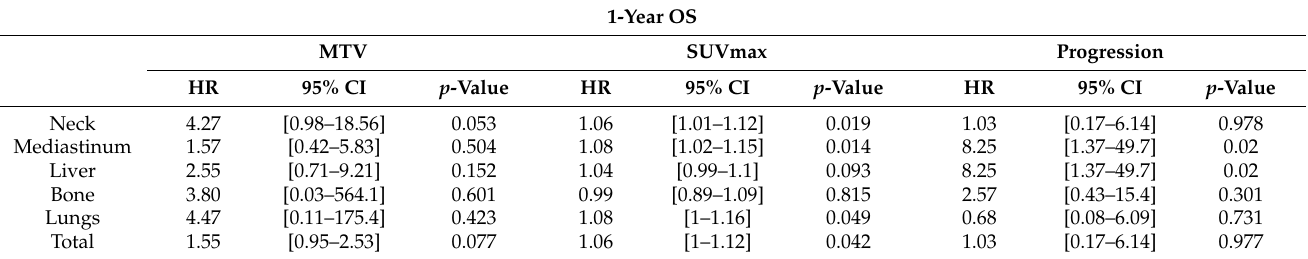
Table 5. Univariate Cox analysis of 1-year OS. HR: hazard ratio.